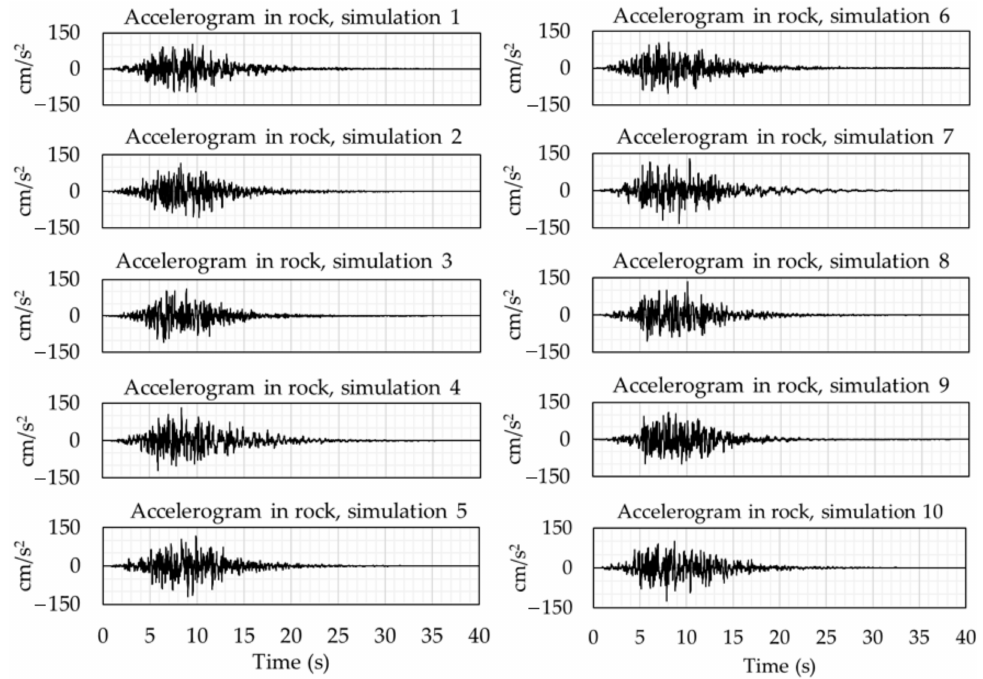
Figure 6. Synthetic accelerograms based on the reference spectrum ER in Puebla, Mexico.